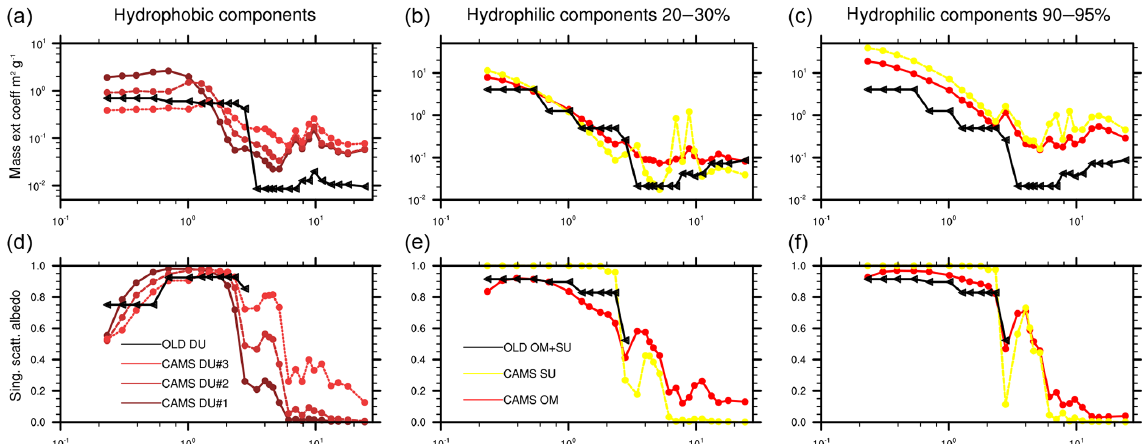
Figure A3. Comparison of optical properties used to describe the radiative effect of the aerosol species in the CAMS model (coloured lines) and in the old climatology based on TG97 (black lines). Values are for the 30 spectral bands of the ECMWF radiation scheme. For the hydrophilic species the mass extinction coefficient is computed with respect to the dry aerosol mass. Panels (a) – (c) show the mass extinction coefficient, and (d) – (f) show the single scatter albedo. Panels (a) and (d) are for the hydrophobic species, mineral dust, and (b) , (e) , (c) and (f) are for the hydrophilic species, organic matter and sulfates, and for the CAMS climatology, shown at two values of relative